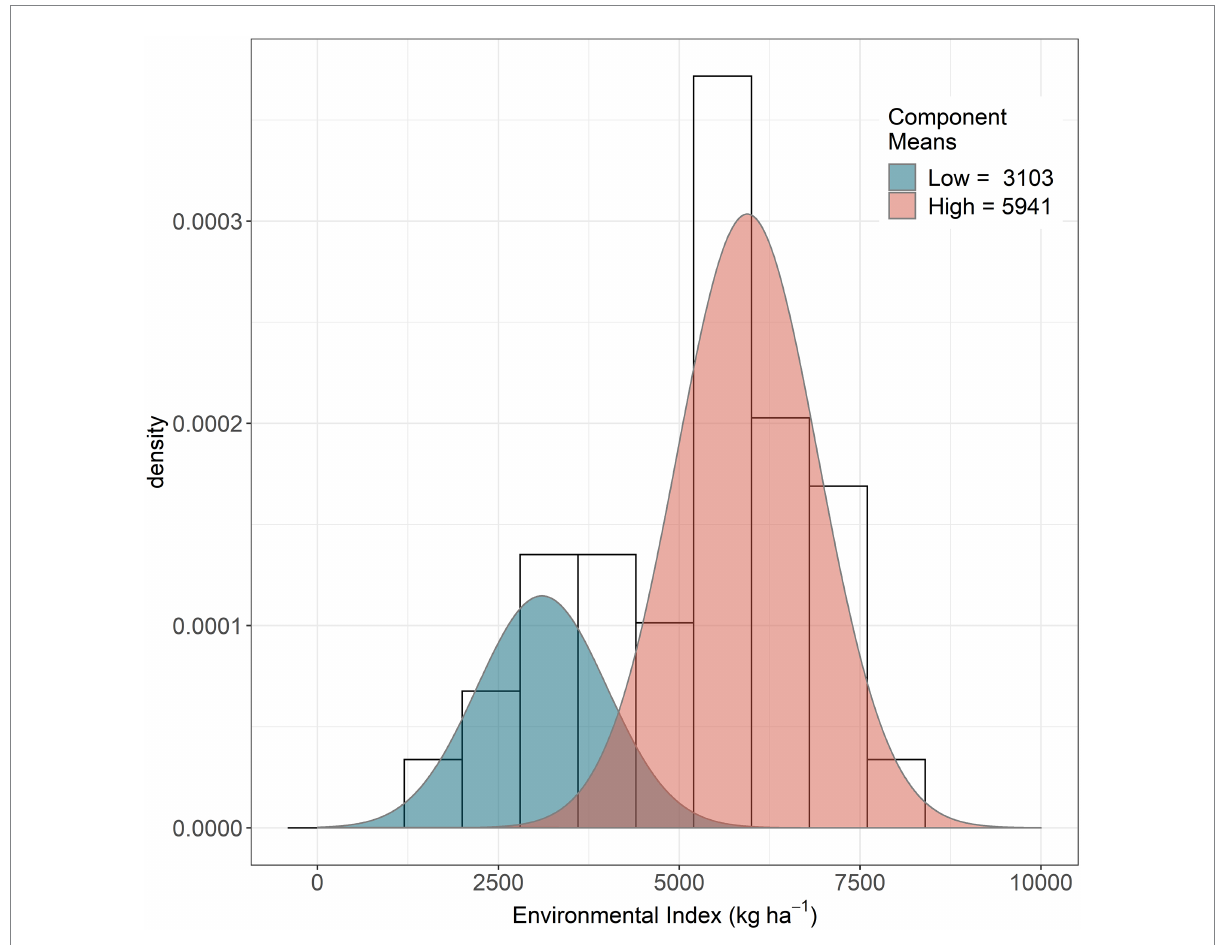
FIGURE 1 Frequency distribution and mean values (kg ha − 1 ) for the low and high environmental index